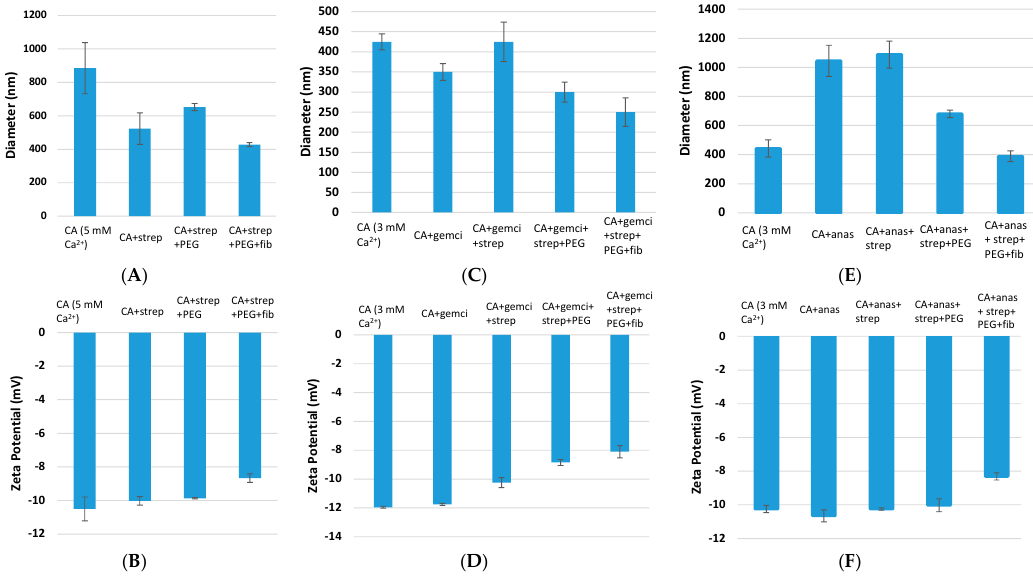
Figure 2. Size and zeta potential measurement of surface-modified, drug-loaded CA particles. CA (fabricated with 3 mM Ca 2+ ) and CA + drug (1 μ M drug concentration) were used as controls. Surface modifications included: CA + drug + streptavidin, CA + drug + streptavidin + biotin–PEG, and CA + drug + streptavidin + biotin–PEG + fibronectin. CA: carbonate apatite; strep: streptavidin; fib: fibronectin; gemci: gemcitabine; anas: anastrozole. ( A ) and ( B ) denote particle diameter and surface charge measurements for unmodified and surface-modified particles without incorporated drugs, ( C ) and ( D ) denote particle diameter and surface charge measurements for unmodified and surface-modified particles with incorporated gemcitabine, and ( E ) and ( F ) denote particle diameter and surface charge measurements for unmodified and surface-modified particles with incorporated anastrozole.